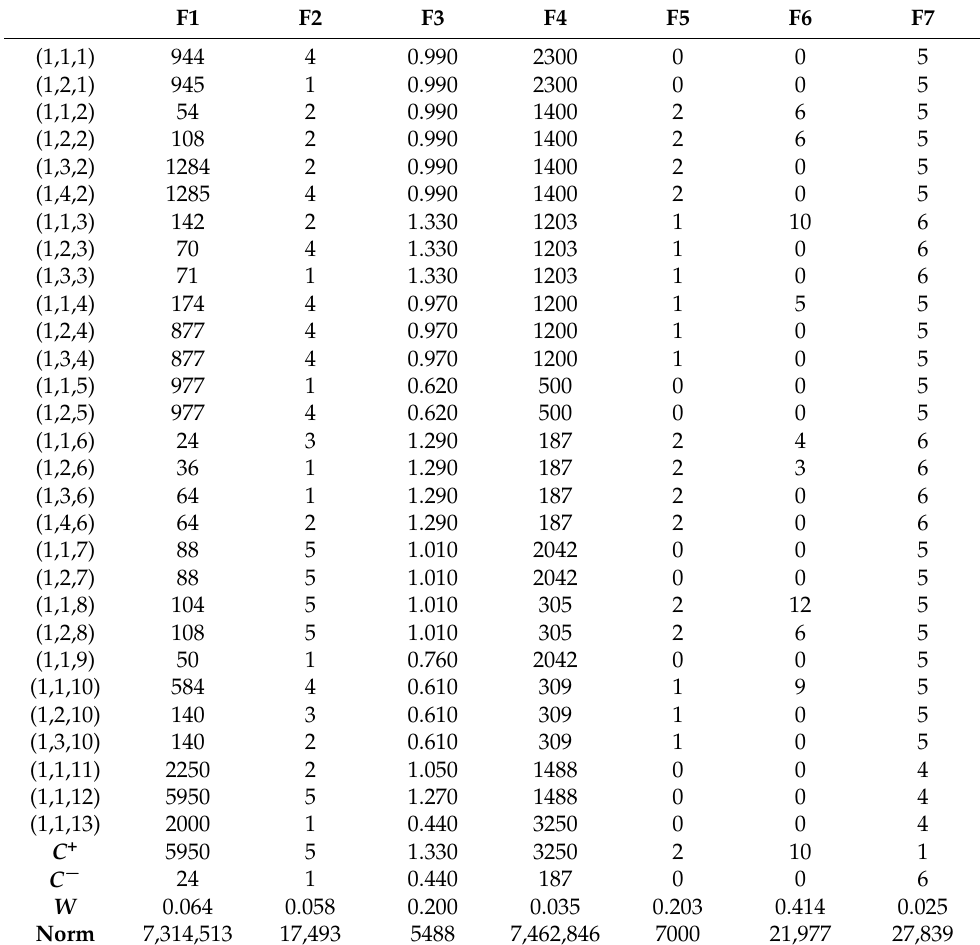
Table A7. The initial decision matrix X in TOPSIS application—1st